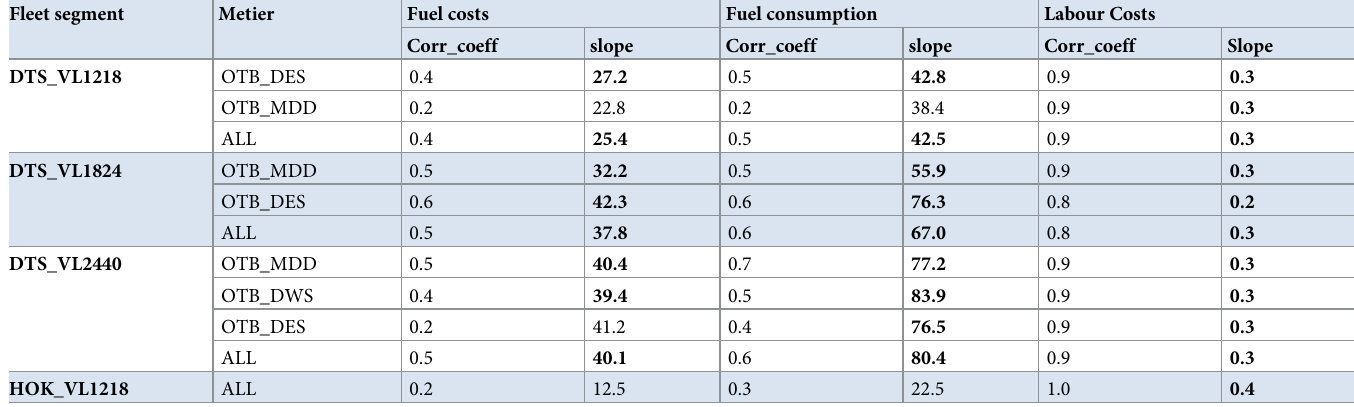
Table 2. Summary of results of the linear regressions by fleet segment and me´tier. In bold are the slopes with p-values < 0.05. Only the me´tiers with a minimum of 30 observations were included in the analysis. Fleet segment